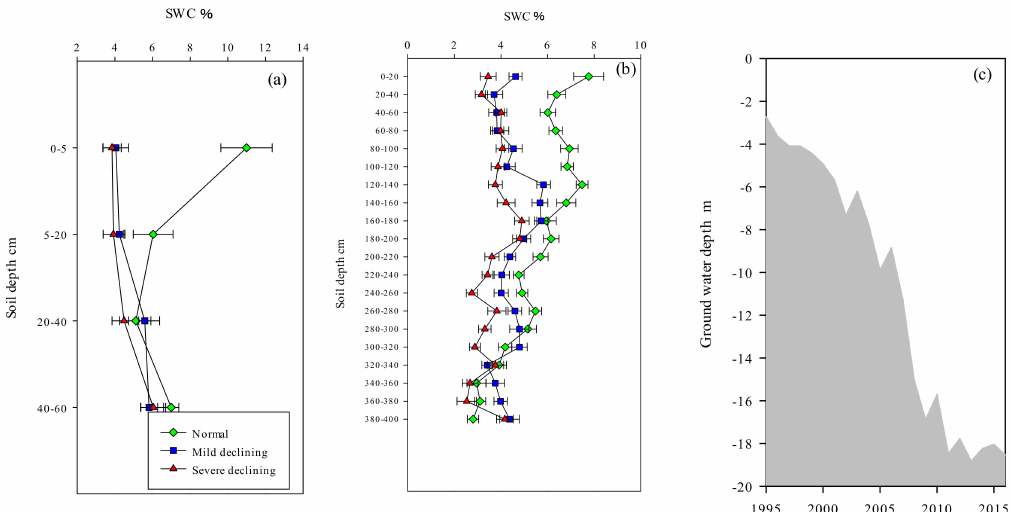
Figure 4. Soil water content at di ff erent soil depths and annual variations of ground water depth during 1995 to 2016: ( a ) soil water content (SWC,%) at 0–60 cm soil depths (the main root distribution of poplar) of normal, mild declining and severe declining P. simonii ; ( b ) soil water content (SWC,%) at 0–400 cm soil depth of normal, mild declining and severe declining P. simonii ; ( c ) ground water depth. Error bars indicate the standard error (SE) of the mean